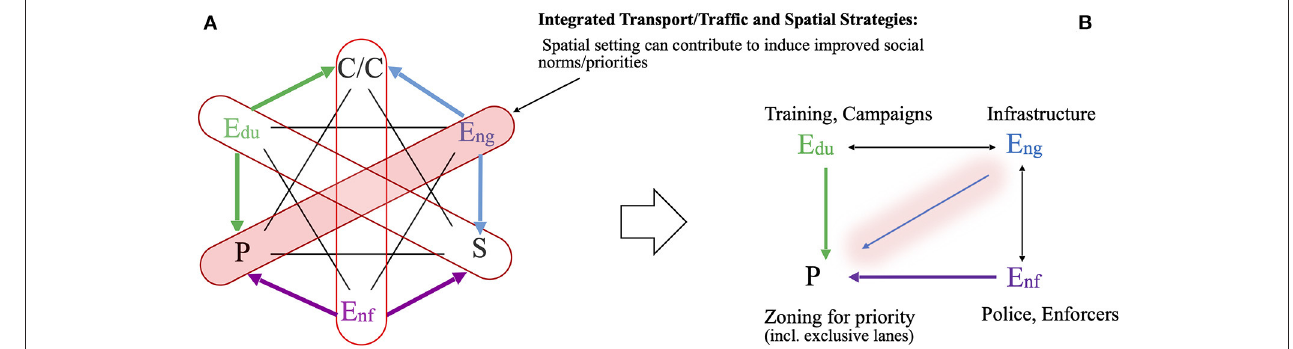
FIGURE 2 | The representation of the analytical framework for this study. (A) Focused cross-sector axis. (B) Proposed conceptual